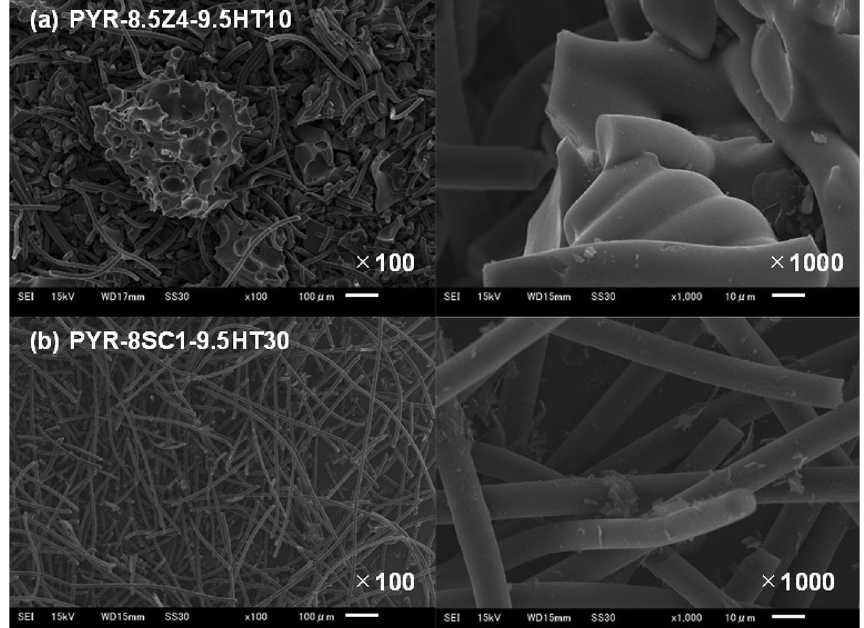
Fig. 1 Morphology of a PYR- 8.5Z4-9.5HT10 and b PYR-